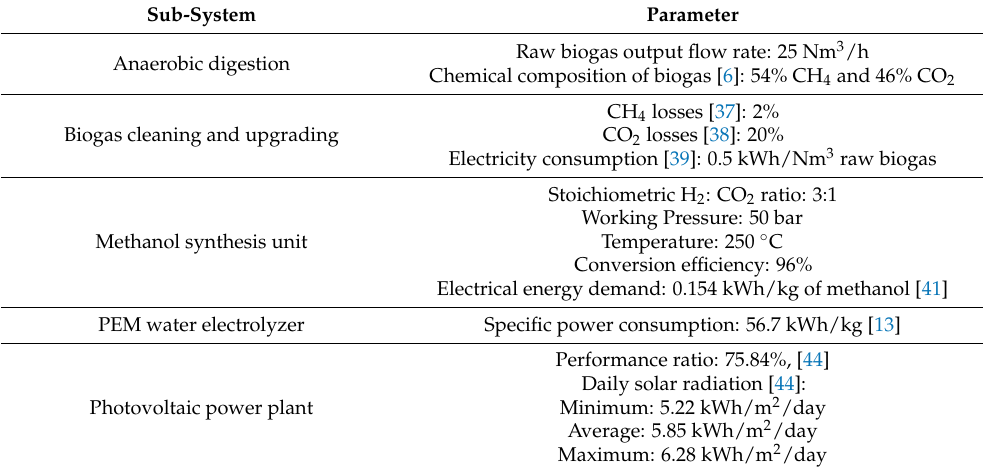
Table 2. Technical parameters of the